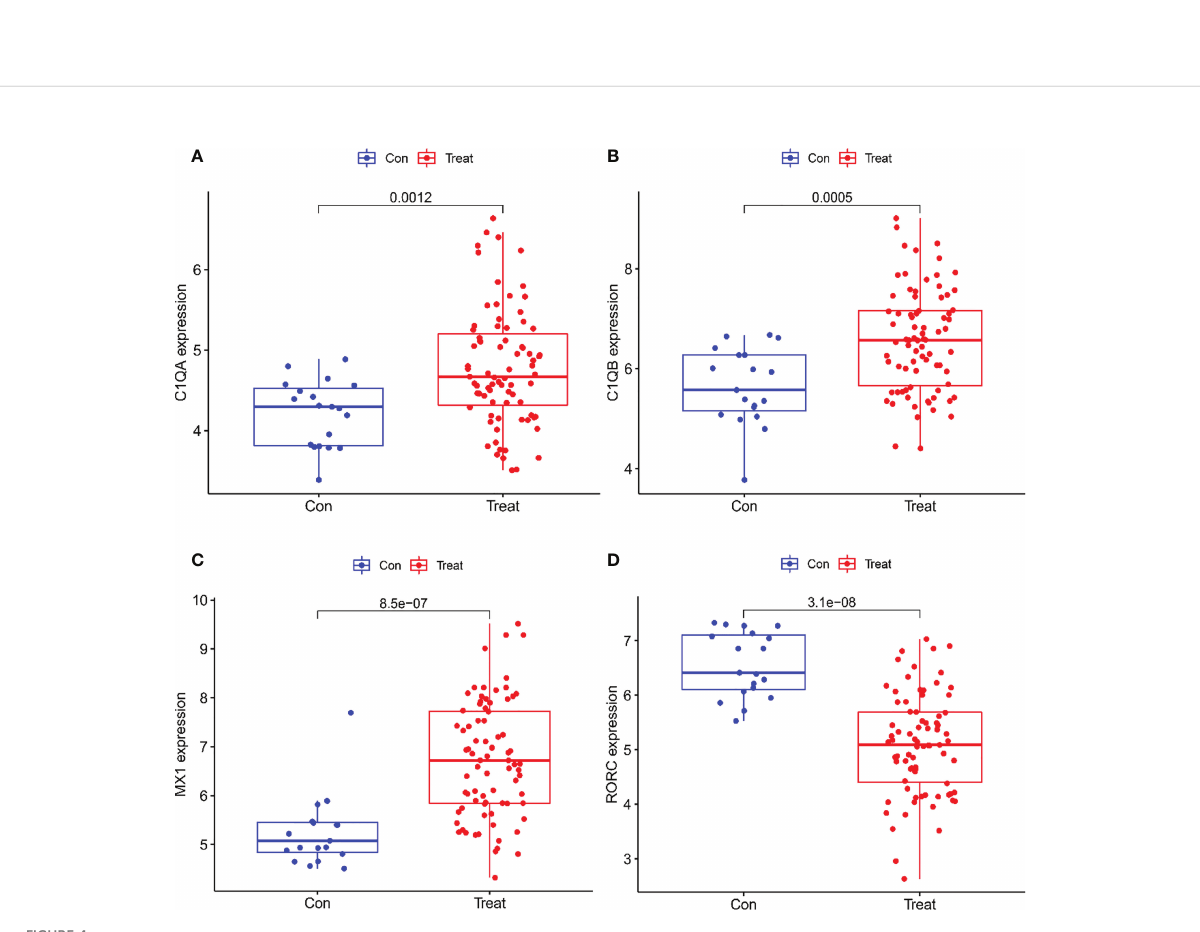
FIGURE 4 Expression of the Four biomarkers in the Validation group GSE200306 dataset. (A) C1QA; (B) C1QB; (C) MX1; (D) RORC.